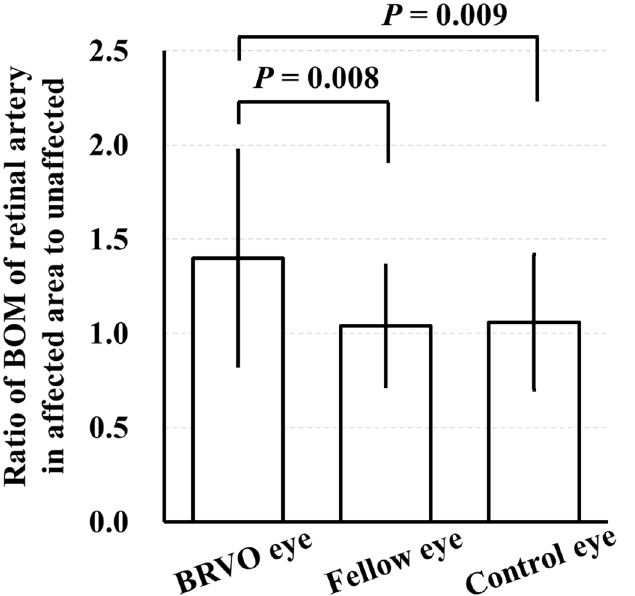
Figure 6. The ratio of BOM of a retinal artery in BRVO-affected retinal area to unaffected area was significantly higher in the BRVO eyes than that in the fellow eyes and control eyes ( P = 0.008, P = 0.009,